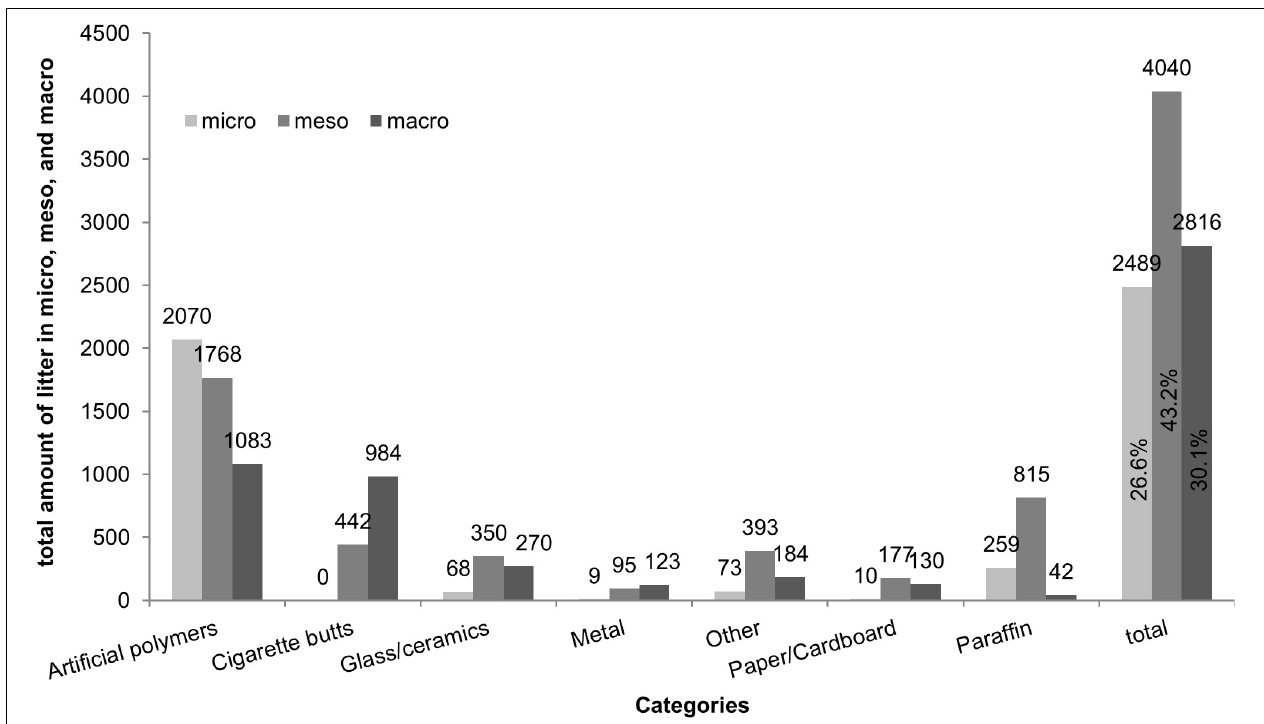
FIGURE 3 | The amount of micro-, meso-, and macro-litter per category and the total amount of litter at the beaches of the Baltic Sea ( n = 197).